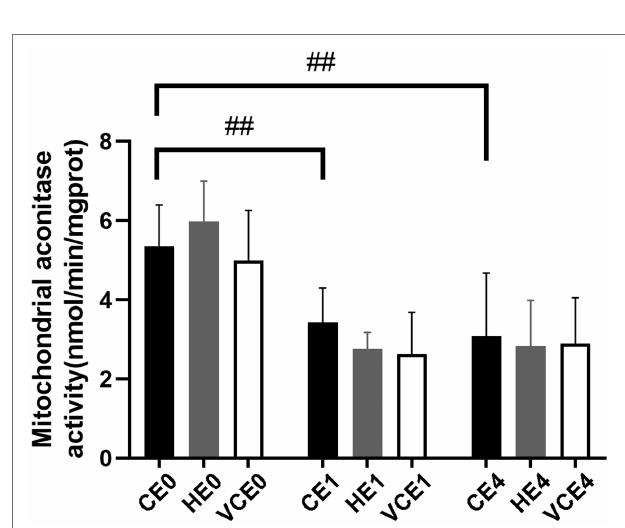
FIGURE 7 | Changes of mitochondria aconitase activity in gastrocnemius muscle before and after exercise. C, blank control; H, inhalation of hydrogen gas; VC, vitamin C supplementation; E0, baseline; E1, immediately after exercise; and E4, 4 h after exercise. n = 8 per group ## p <